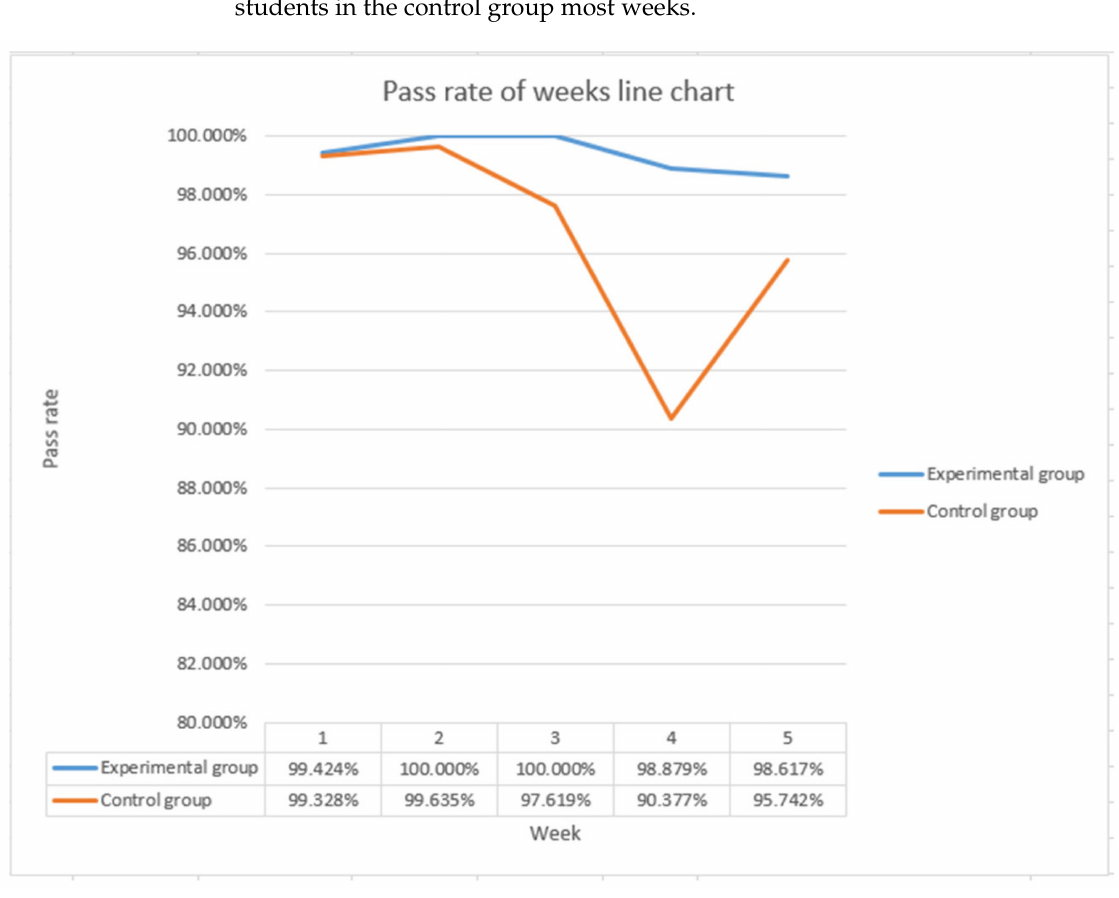
Figure 38. Line chart showing the weekly pass rate of the